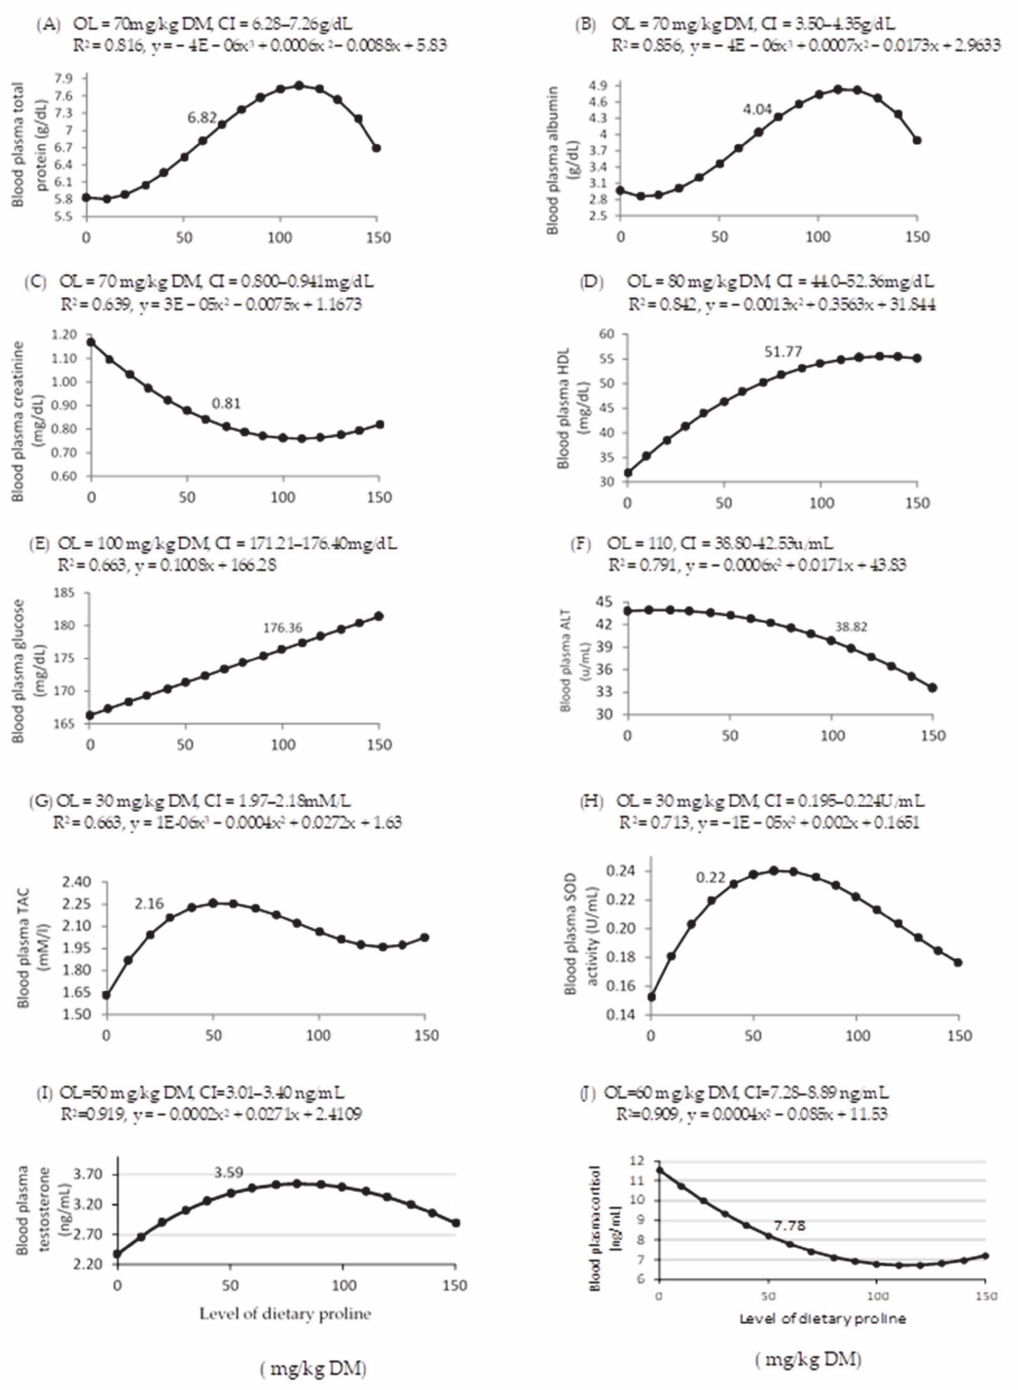
Figure 3. Dose–response curve of blood plasma total protein ( A ), albumin ( B ), creatinine ( C ), high density lipoprotein (HDL, ( D )), glucose ( E ), alanine aminotransferase (ALT, ( F )), total antioxidant capacity (TAC, ( G )), superoxide dismutase activity (SOD, ( H )), testosterone ( I ), and cortisol ( J ) for different levels of dietary supplemental proline. DM = dry matter, OL = optimum level of dietary supplemental proline and CI = confidence interval, R 2 = regression value, and x and y are the dependent variable (proline level) and the independent variable of the regression equation, respectively. The figure only shows significant relationships ( p <